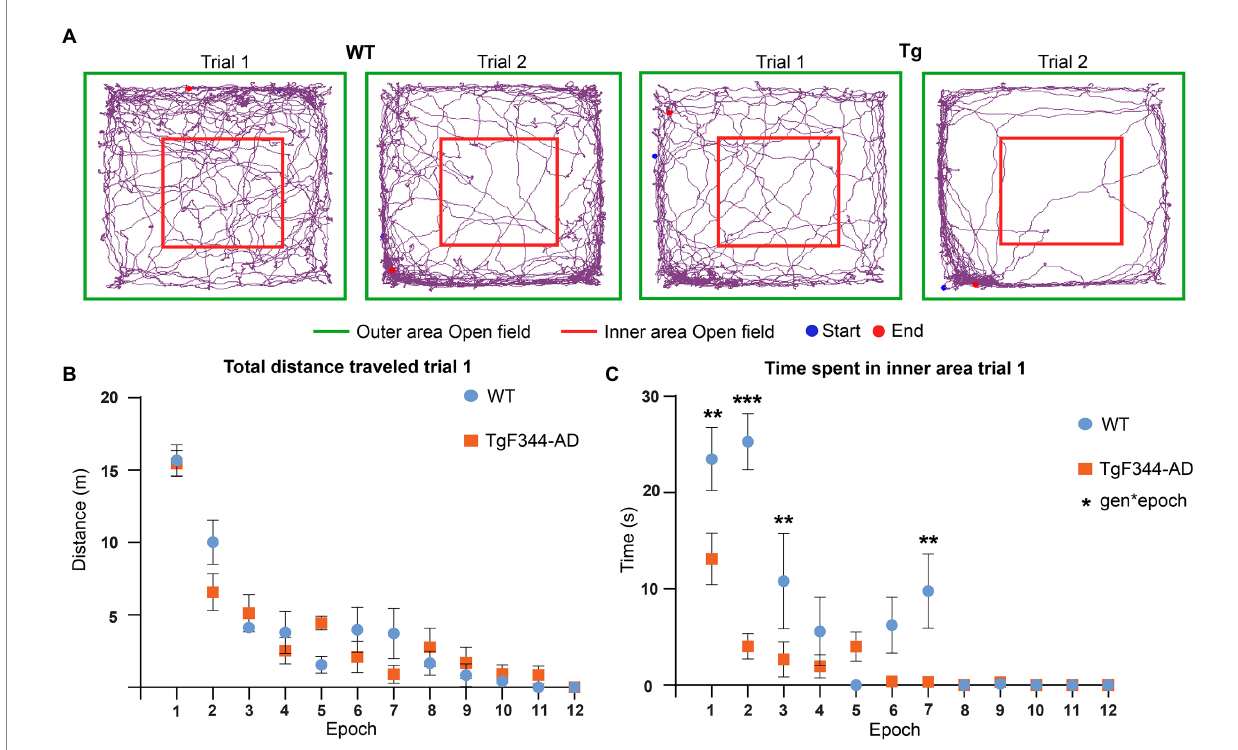
FIGURE 5 Behavioral analysis OFT during trial 1. (A) Movement traces of representative wild-type (WT) (left) and TgF344-AD (Tg) (right) rat during trial 1 and trial 2. The start position is indicated with the blue dot and the end position is indicated with the red dot. The 1 × 1 m open field is divided into an inner area (red) and outer area (green). (B) Total distance traveled in meters across different 5-min epochs during trial 1. (C) Time spent in seconds in the inner area of the open field across different 5-min epochs during trial. Plots represent mean ± SEM. ** q ≤ 0.01, *** q ≤